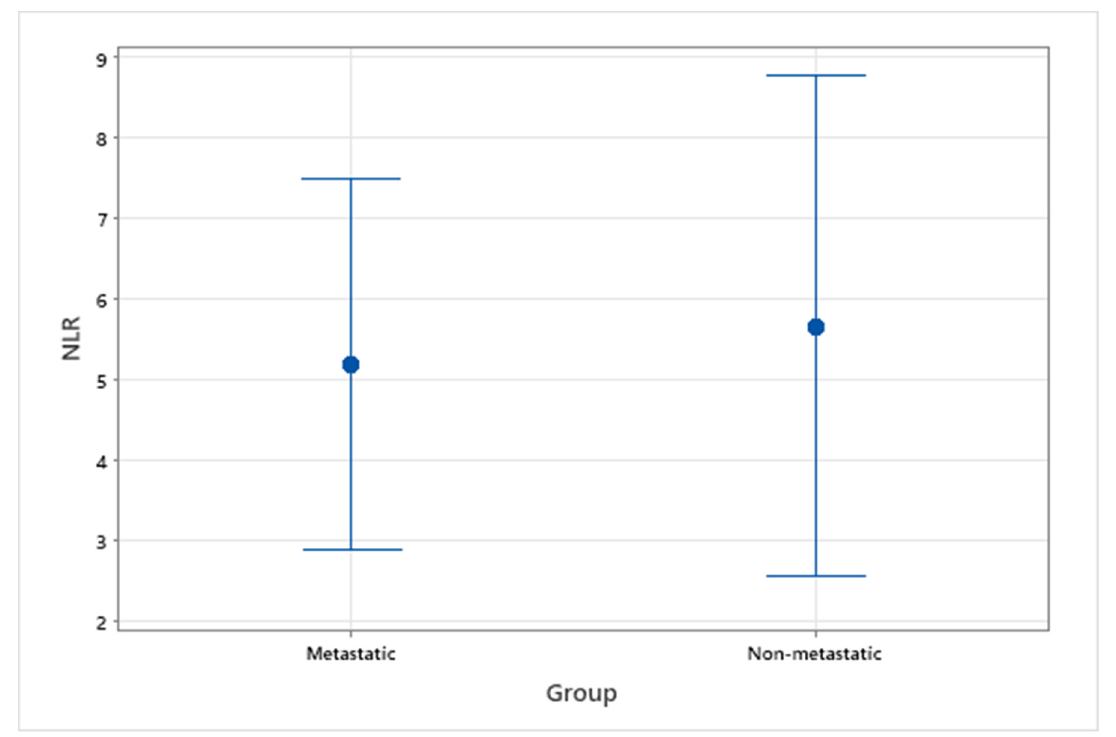
Figure 3. Interval plot of pre-treatment NLR in patients with OMM, with and without evidence of metastasis.